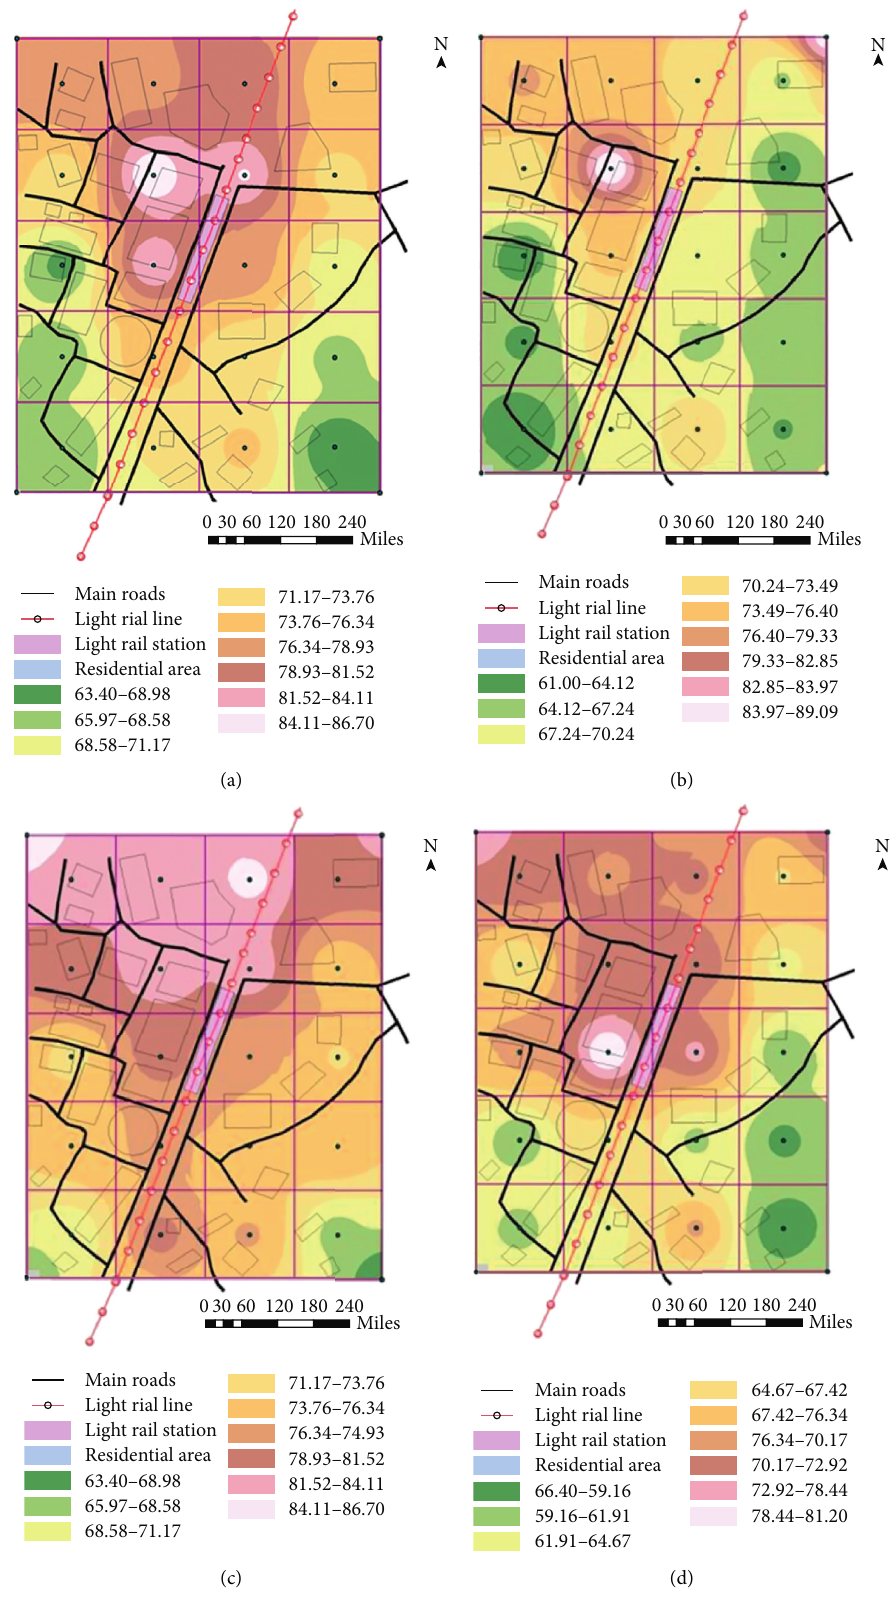
Figure 10: The acoustic environment for Sunday. (a) 7:00 a.m. (b) 12:00 p.m. (c) 06:00 p.m. (d) 10:00